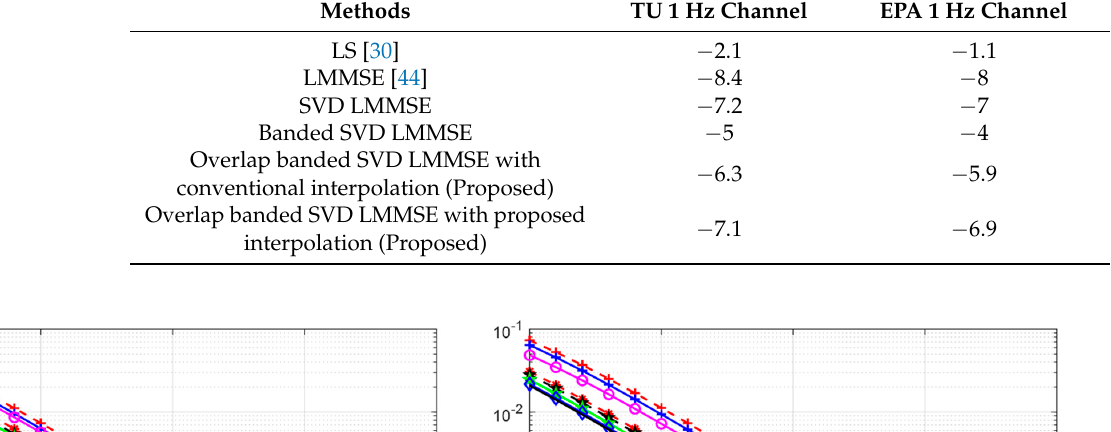
Figure 10. Mean square error (MSE) comparison of the proposed technique with conventional and proposed interpolation methods for different subvector values: ( a ) TU 1 Hz; ( b ) EPA 1 Hz.